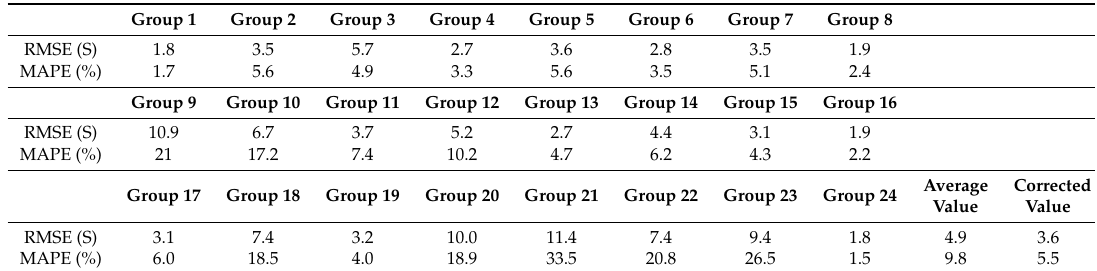
Table 7. Error evaluation in predicting phase for WordCount sample.